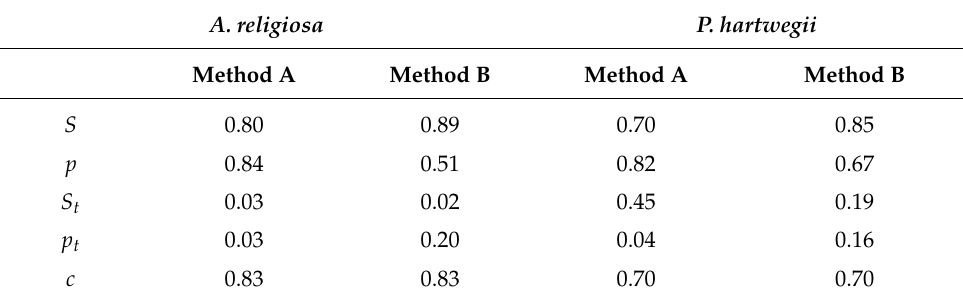
Table 8. Estimated values of the canopy structure